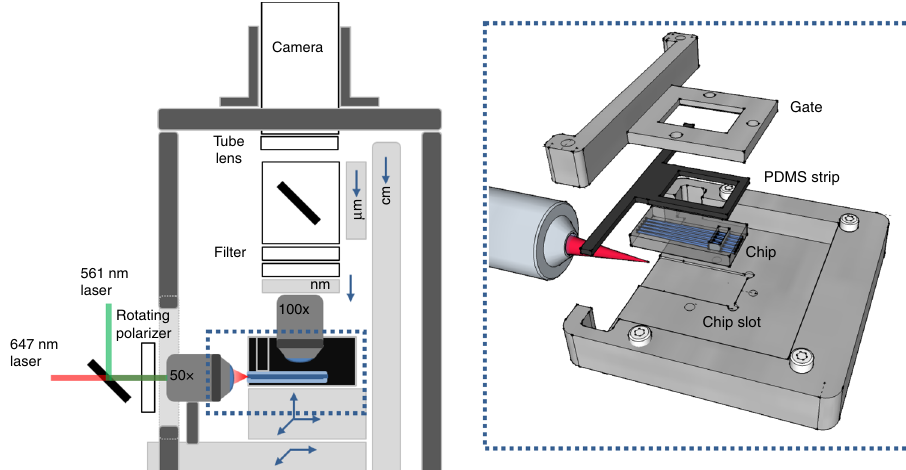
Fig. 2 Waveguide chip holder and upright microscope for waveguide-PAINT. The proposed DNA-PAINT microscope is designed with two independent arbors: one axle (dark-gray) holds the heaviest components that do not need Z adjustments while a three-gauges system (light gray) provides large (centimeter range), micrometric and nanometric positioning. The waveguide holder (dashed blue line) enables a free space coupling through a X-Y-Z nanometric stage placed on top of the X-Y stage for FOV adjustments. The holder design presents a precision slot to position and orient the waveguide chip properly with respect to the laser line, and a sealing gate to hold the imaging buffer and to shield scattered